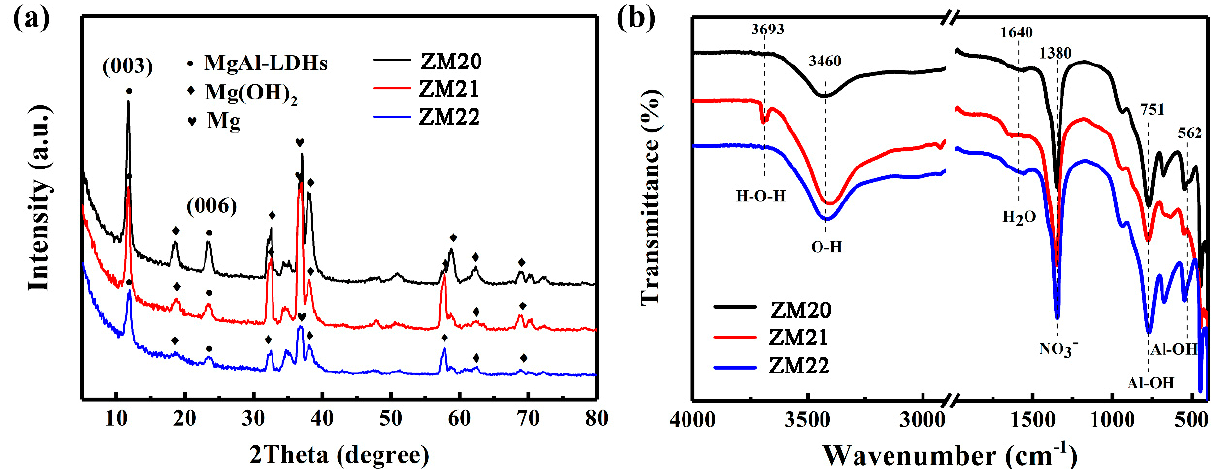
Figure 5. ( a ) XRD patterns and ( b ) FTIR spectra of ZM20 - LDHs, ZM21 - LDHs, and ZM22 - LDHs films.